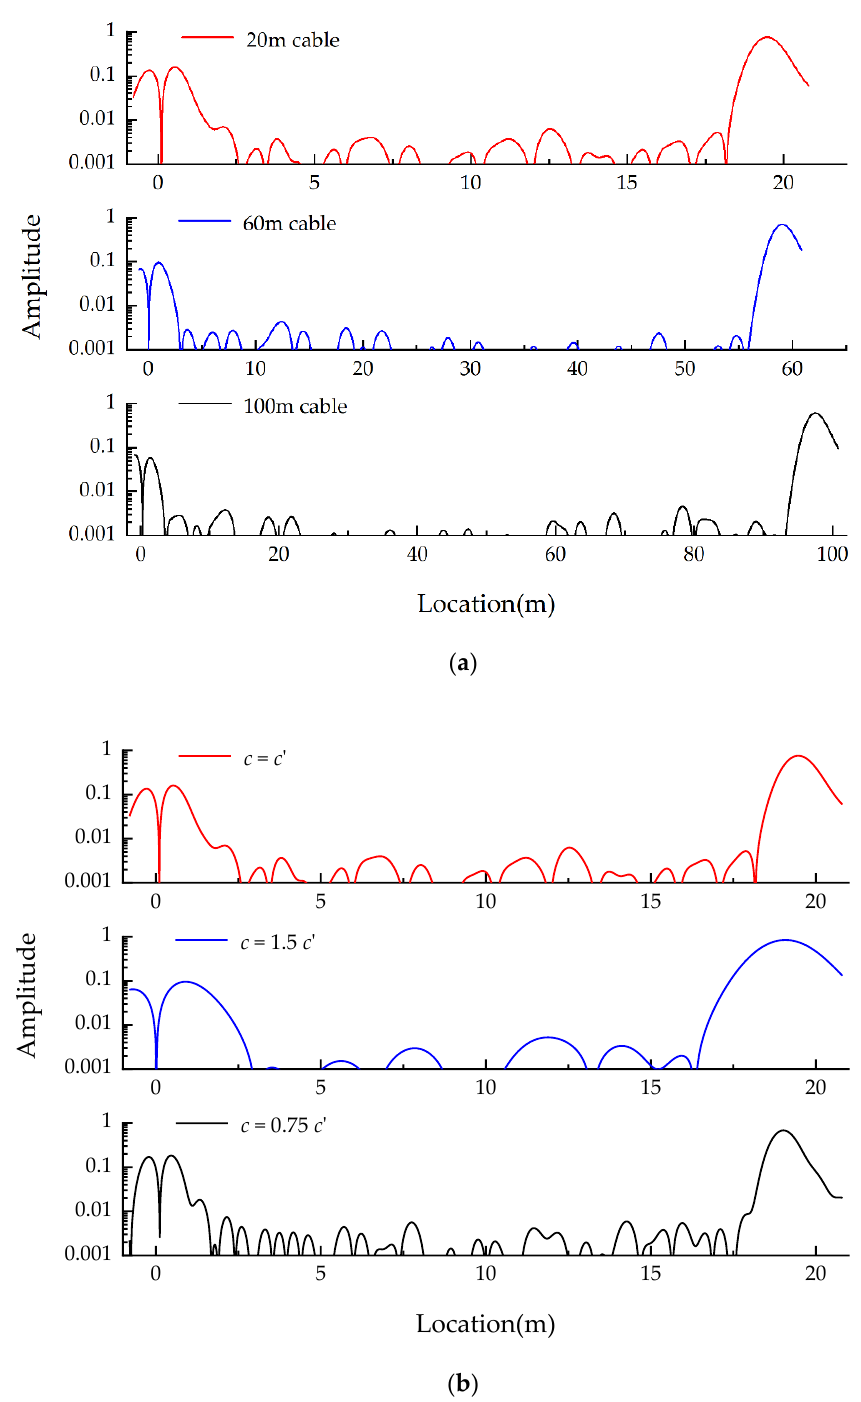
Figure 4. Location spectra of different cables: ( a ) Different lengths; ( b ) Different pulse widths c.